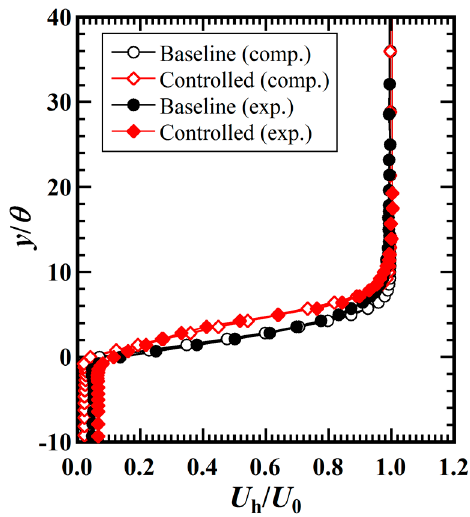
Figure 12. Predicted and measured mean velocity profiles with and without control ( x / L = 0.05, z = z pa ).